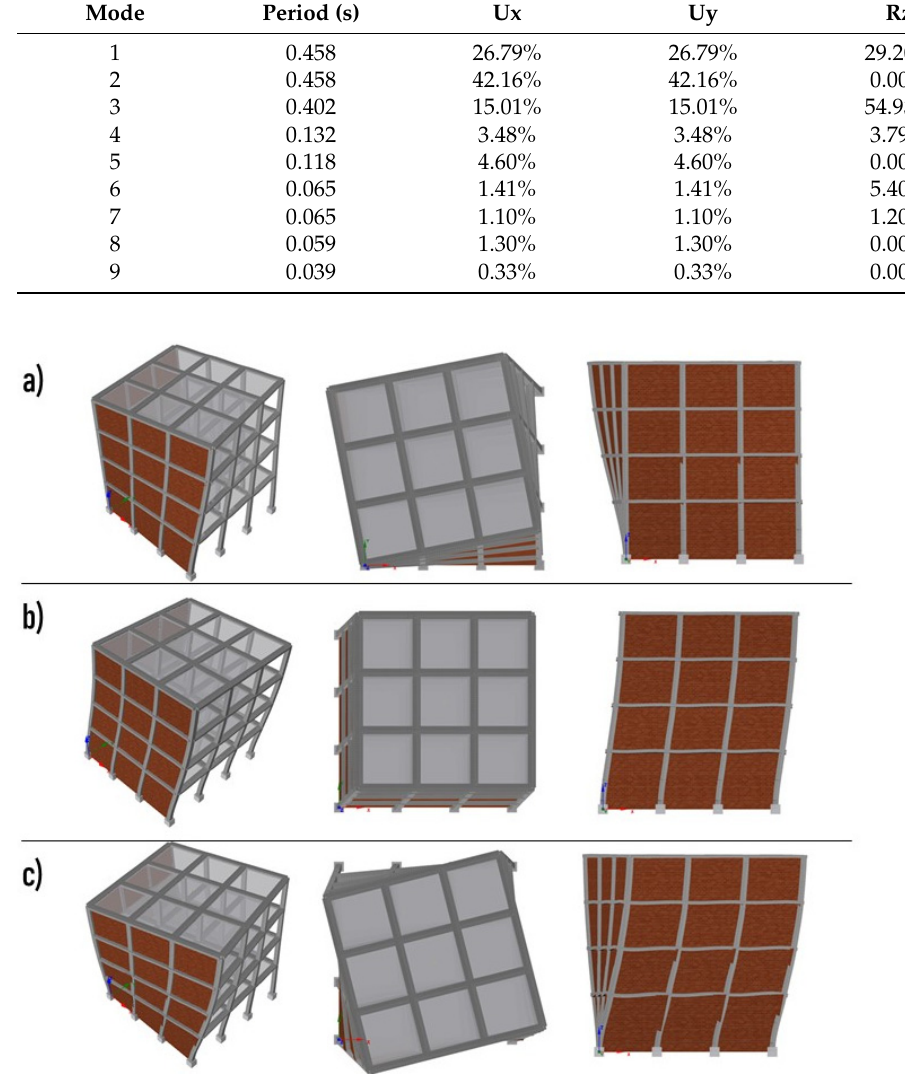
Figure 7. Perspective, plan, and front views of the deformed shapes corresponding to the ( a ) first mode, ( b ) second mode, and ( c ) third